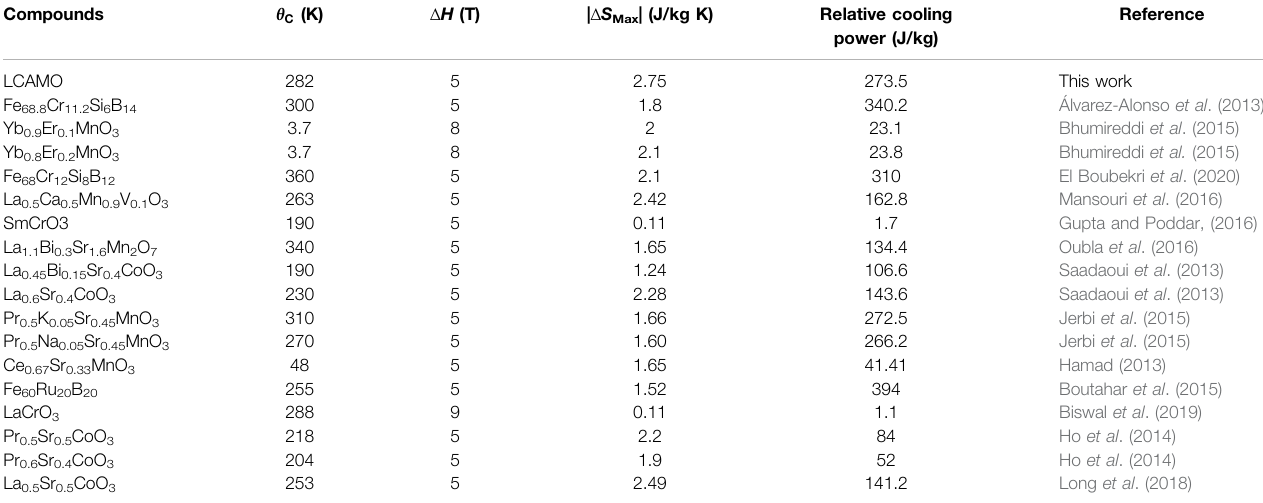
TABLE 1 | The comparison of magnetocaloric effect parameters for La 0.5 Ca 0.1 Ag 0.4 MnO 3 (LCAMO) with corresponding ones of various magnetocaloric effect materials in high Δ H . Compounds θ C